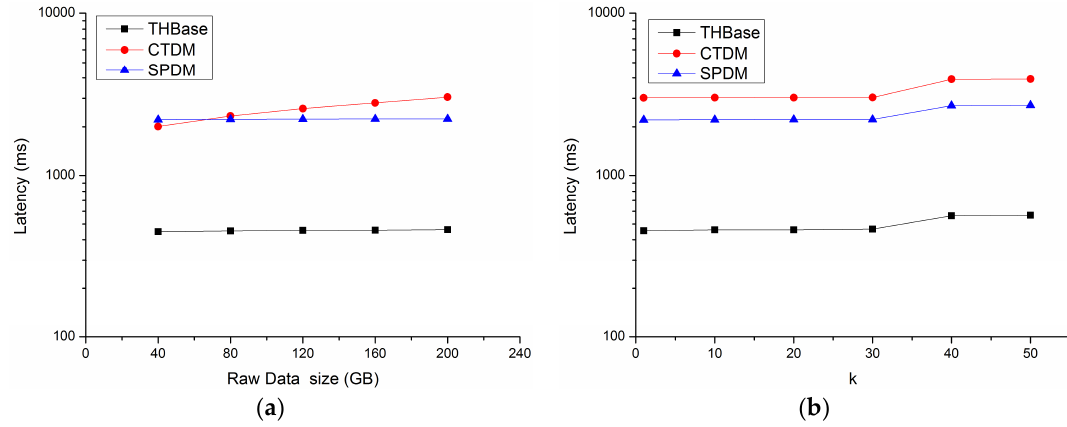
Figure 7. Performance of k-NN query: ( a ) result of changing data size, ( b ) result of changing k.